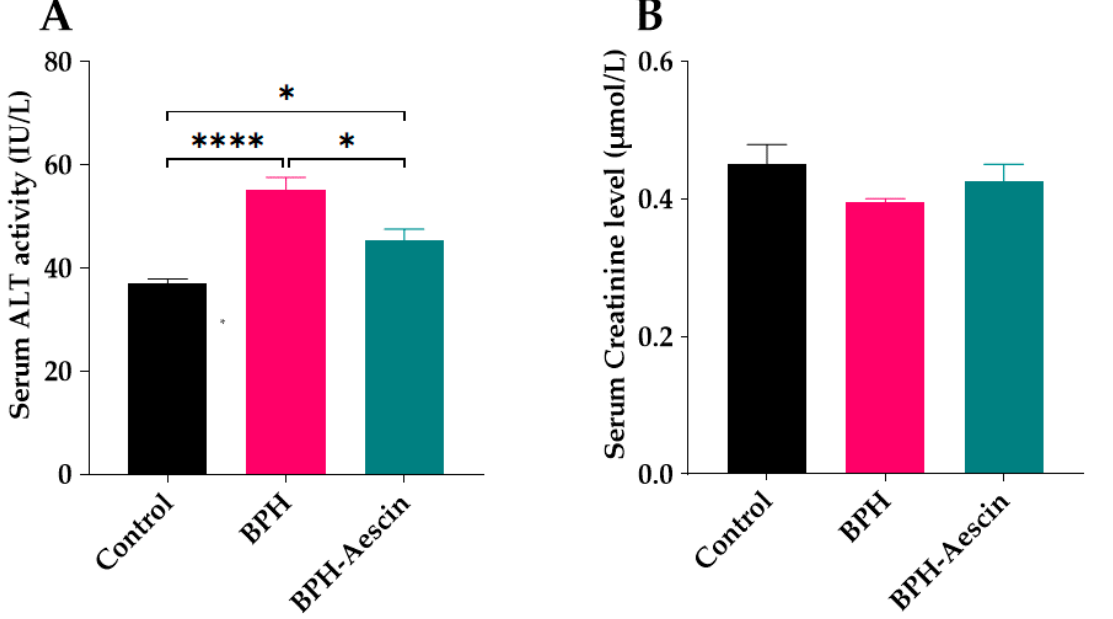
Figure 8. Effect of aescin on serum of ALT and creatinine levels in BPH rats. Serum samples were collected from control, BPH, and BPH–aescin groups, and were used for determination of the activity ALT ( A ) as a hepatic function marker, and creatinine level ( B ) as a surrogate of renal function. Colorimetric assay kits were used in these tests. Rats were subjected to a 4-week treatment protocol of sesame oil (control), testosterone (3 mg/kg, s.c.) dissolved in sesame oil (BPH), or testosterone (3 mg/kg, s.c.) dissolved in sesame oil + aescin (10 mg/kg, p.o.) (BPH–aescin). Data (mean ± SEM, n = 5) were analyzed by one-way ANOVA followed by Tukey’s multiple comparisons test. * and **** denote significant differences between the selected study groups at p values < 0.05 and 0.0001, re-